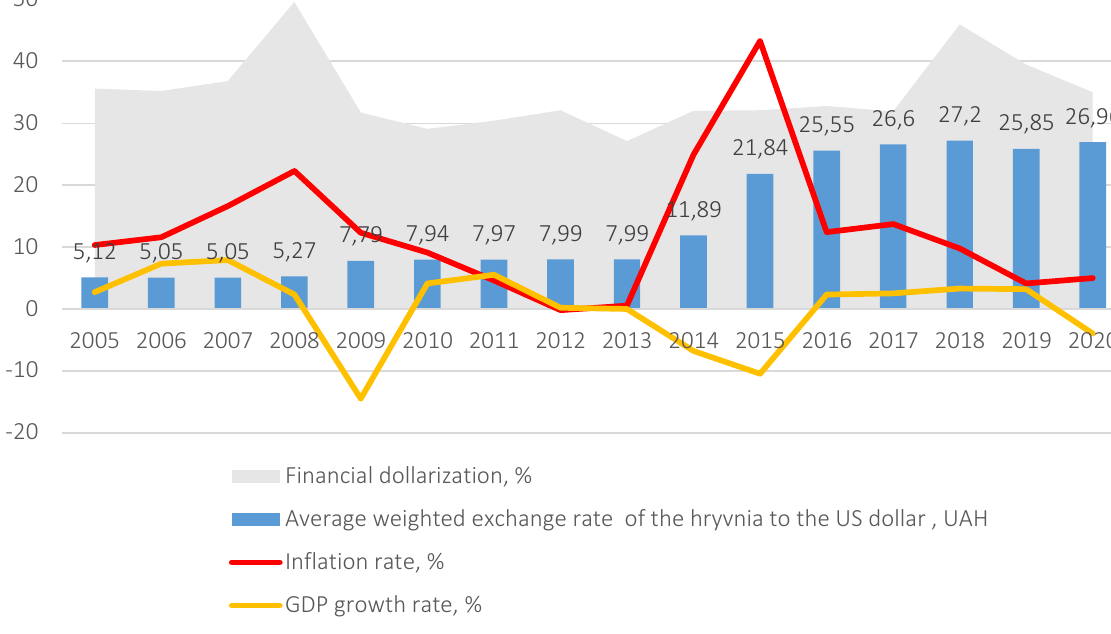
Figure 9. Values of indicators characterizing the MTM exchange rate channel in Ukraine in